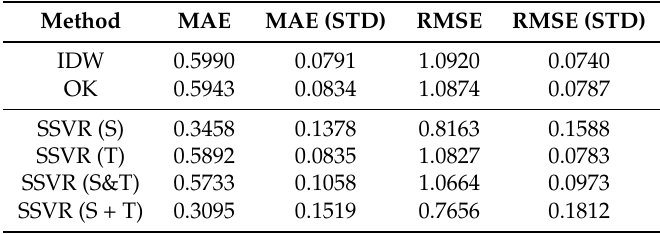
Table 4. Results under the coverage hole setting (without synthetic sensors).